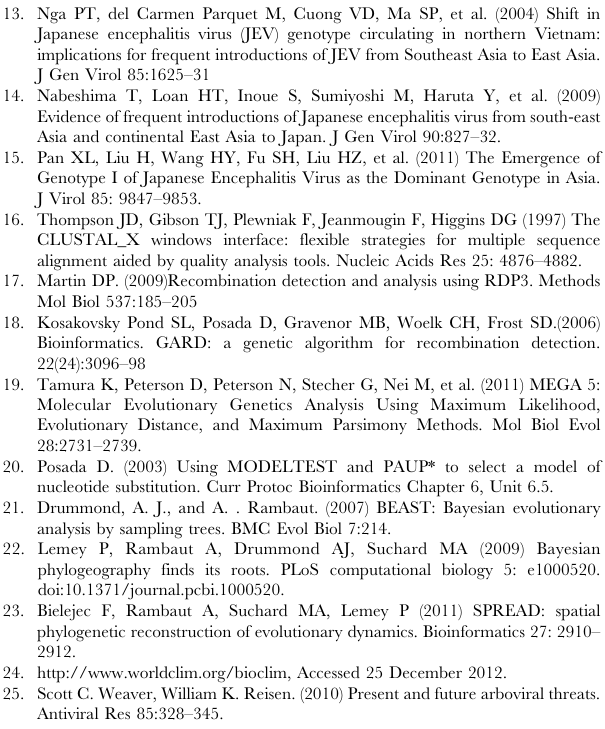
Table S1 JEV strains used in the present study for phylogenetic